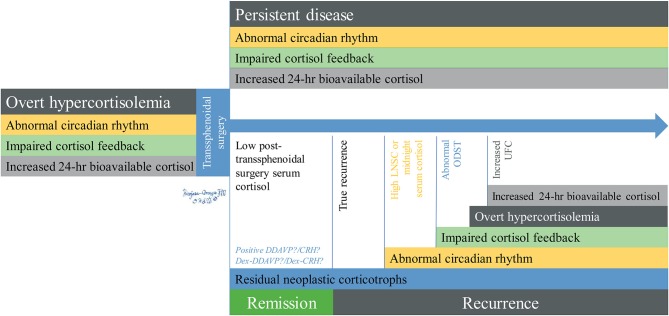
Chronological changes of recurrent hypercortisolemia in Cushing's disease. Overt hypercortisolemia is characterized by abnormal circadian rhythm which can be assessed by LNSC, impaired feedback shown by lack of suppression of ACTH/cortisol after dexamethasone, and increased levels of bioavailable cortisol measured by UFC. After TSS, patients with persistent disease will retain these abnormalities while they will resolve in the ones who experience remission, who will also have low post-TSS serum cortisol (remission) or normalized during the first ~25 days post-op (delayed remission). Residual neoplastic corticotrophs may be identified during remission or early recurrence by DDAVP/Dex-DDAVP and potentially by CRH/Dex-CRH. Abnormal circadian rhythm is the first abnormality that appears after recurrence, followed by impaired cortisol feedback, and finally by overt hypercortisolemia. DDAVP testing for hypercortisolemia is rarely performed in the United States. ACTH, adrenocorticotropic hormone; CRH, corticotropin releasing hormone stimulation test; DDAVP, desmopressin stimulation test; Dex-DDAVP, desmopressin stimulation test after low-dose dexamethasone suppression test; Dex-CRH, corticotropin releasing hormone stimulation test after low-dose dexamethasone suppression test; LNSC, late-night salivary cortisol; ODST, overnight dexamethasone suppression test; UFC, 24-h urinary free cortisol; TSS, transsphenoidal surgery.